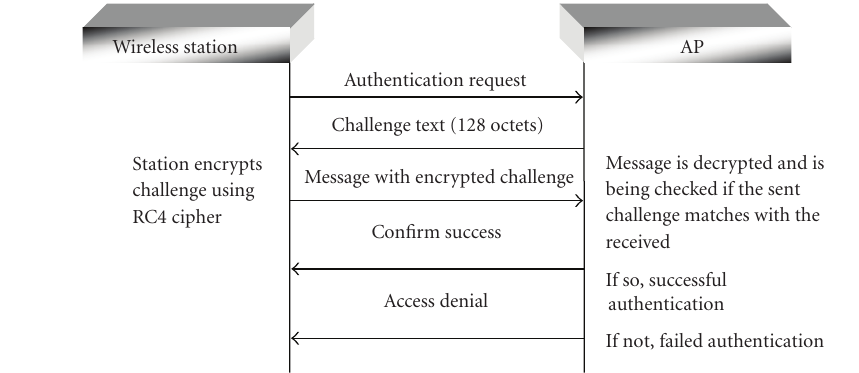
Figure 1: WEP confidentiality and integrity procedure.